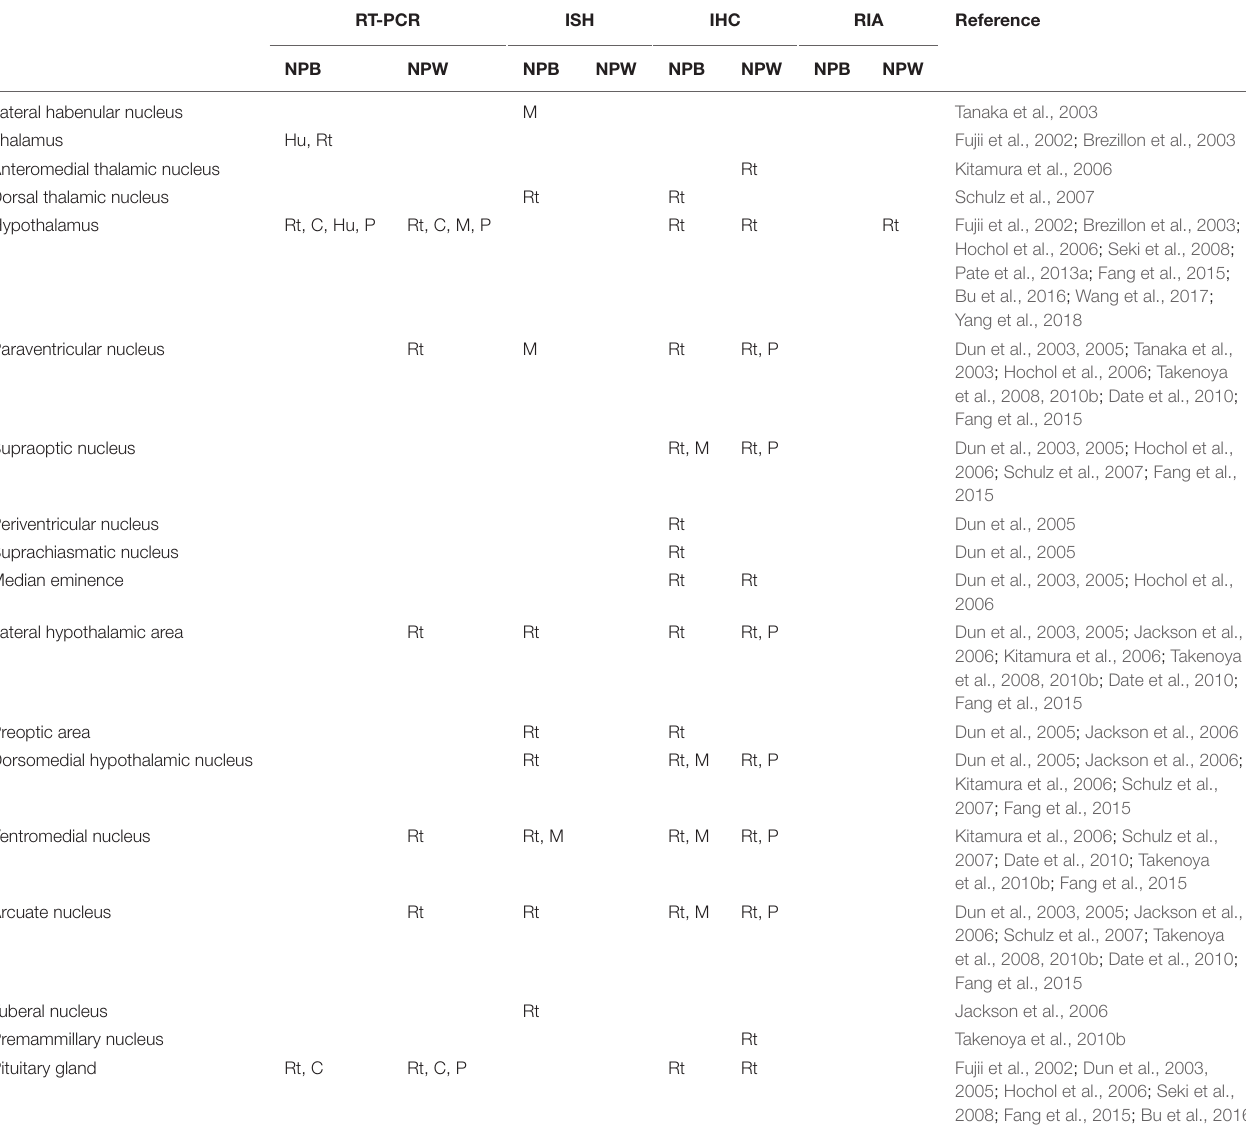
TABLE 2 | Localization of NPB and NPW in the